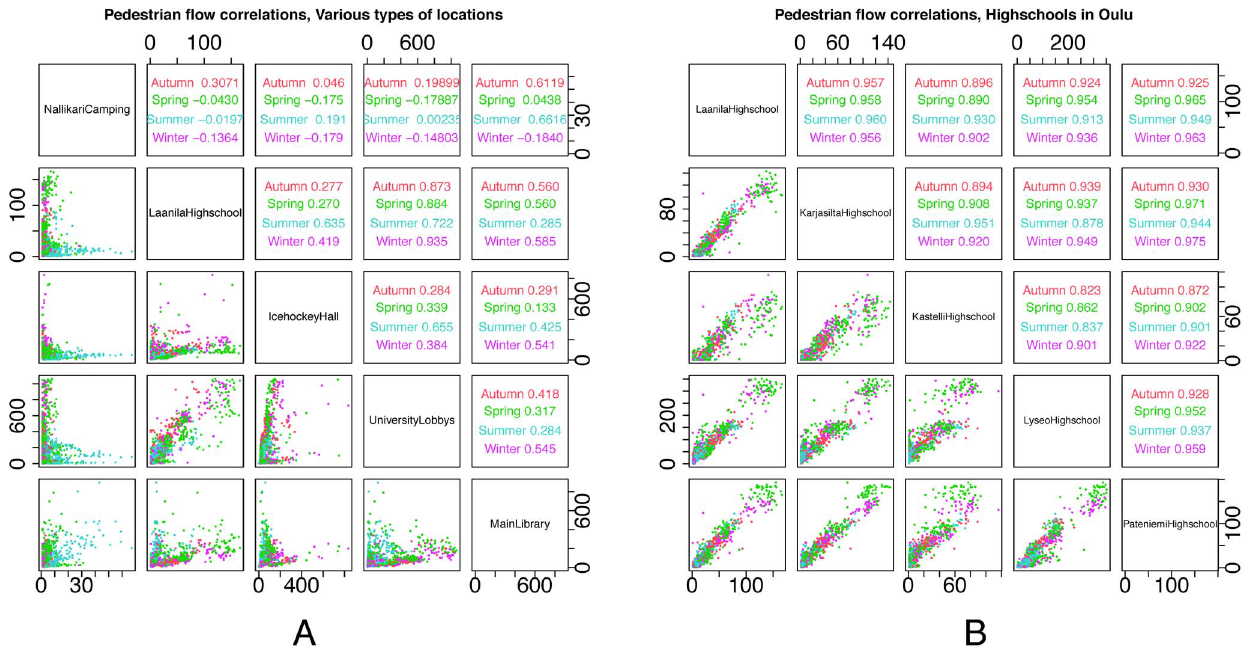
Figure 5. Scatterplot matrices showing pedestrian flow. Here we can see pedestrian flows for (a) various types of locations and (b) high schools. In this figure each scatterplot is for a pair of locations. Each scatterplot data point is for a particular day of our study, and indicates the correlation of pedestrian flows for the two locations on that particular date. Data points are color-coded by season to account for seasonal variations. Reading the scatterplots: to locate the scatterplot for a pair of locations, the row-column intersection cell need to be inspected below the diagonal. Similarly, the correlation values are at the row-column intersection cell above the diagonal.